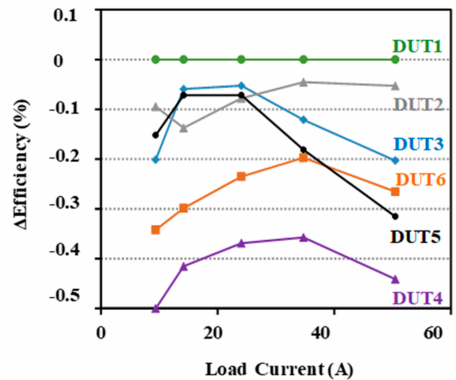
Figure 9. Di ff erential e ffi ciencies of the LLC resonant converter with respect to the best SJ-MOSFET (DUT1).